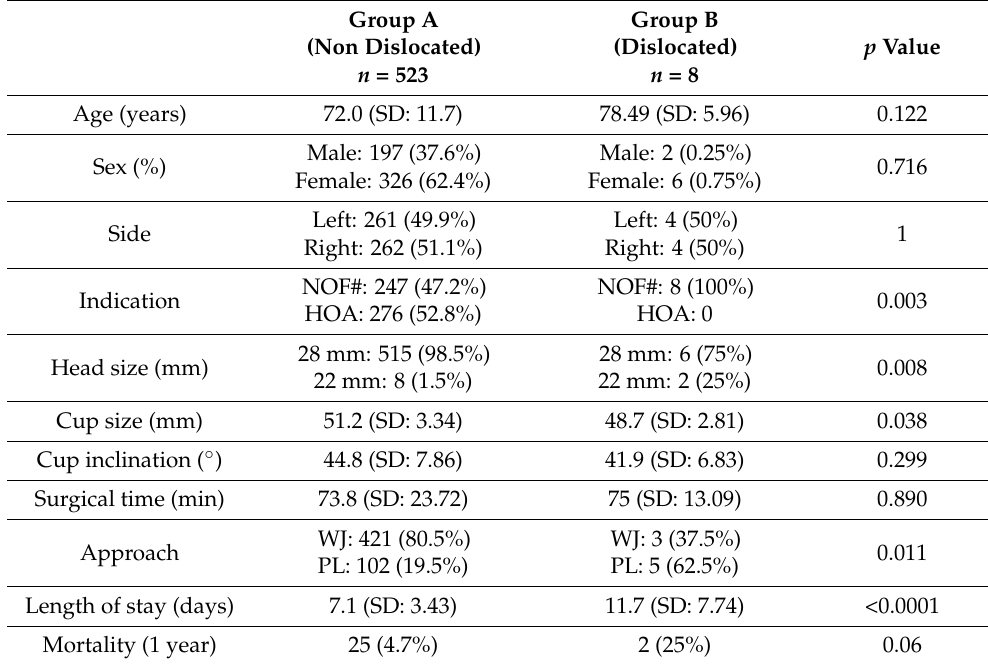
Table 2. Risk factors associated with a dislocation event. Group A: patients who did not sustain a dislocation). Group B: patients who presented a dislocation during